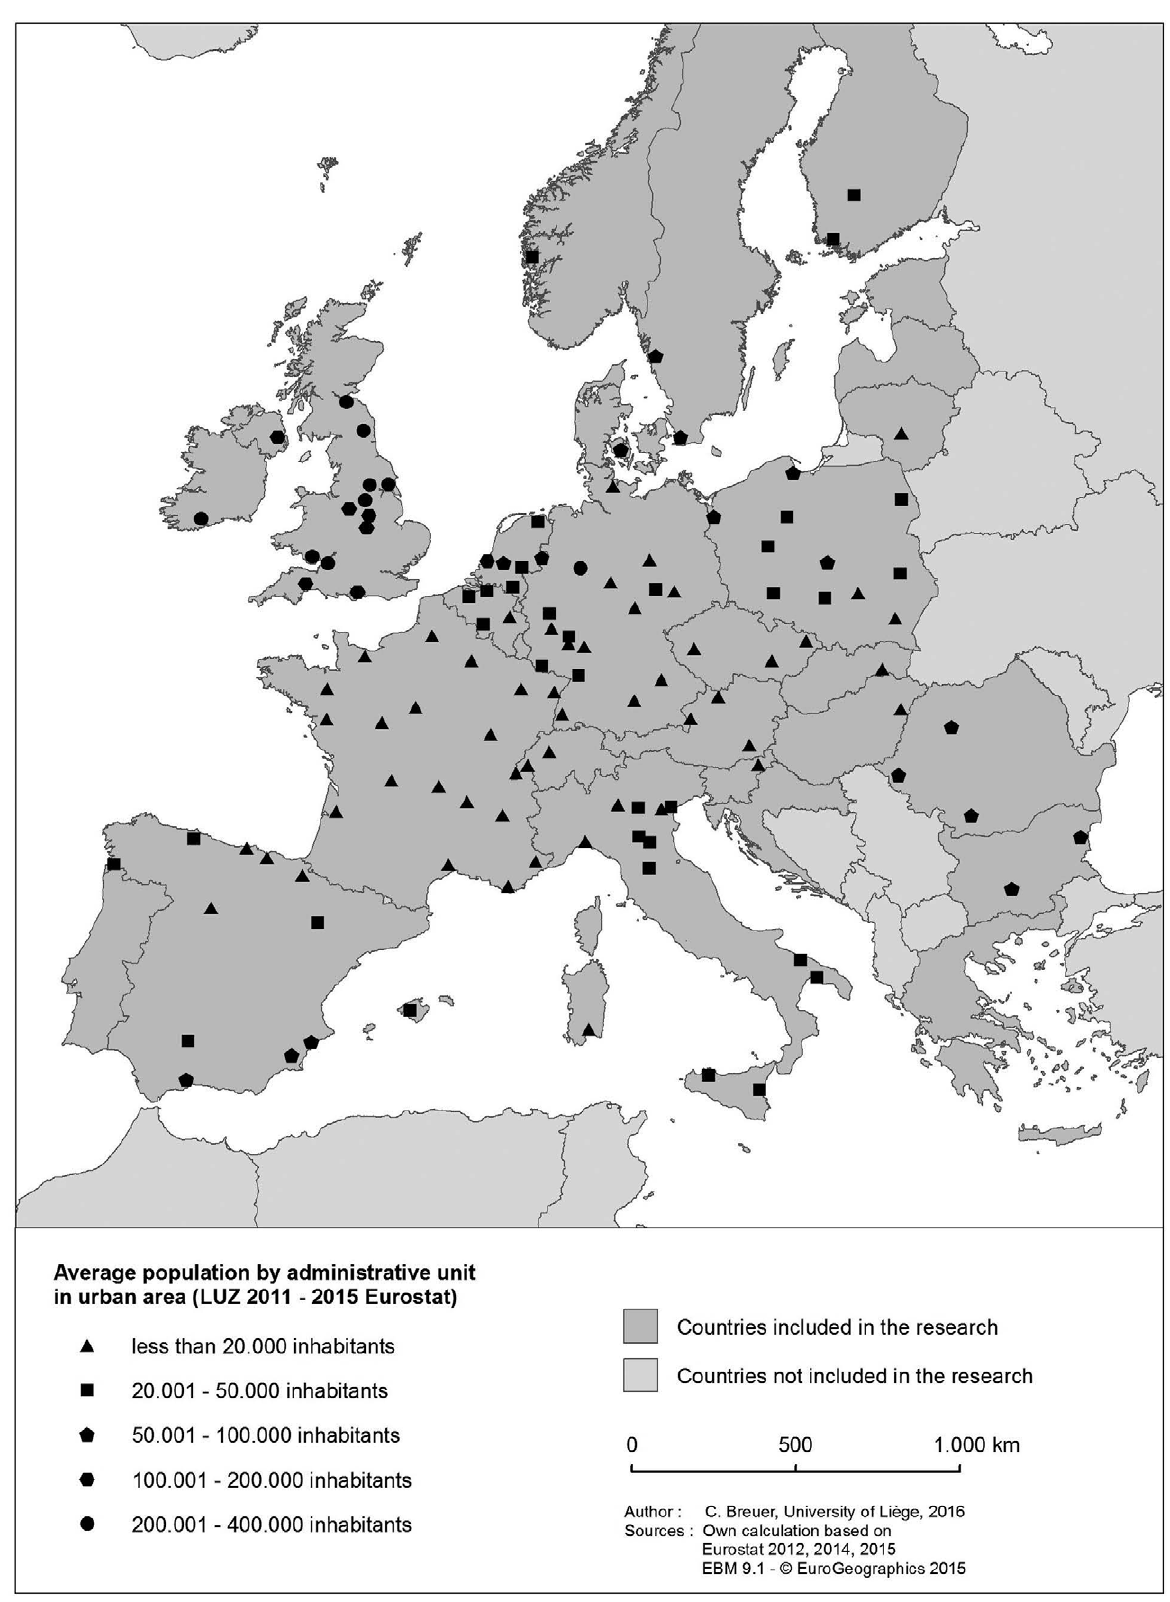
Fig. 9. Map of an average population by local unit in 119 intermediate European urban